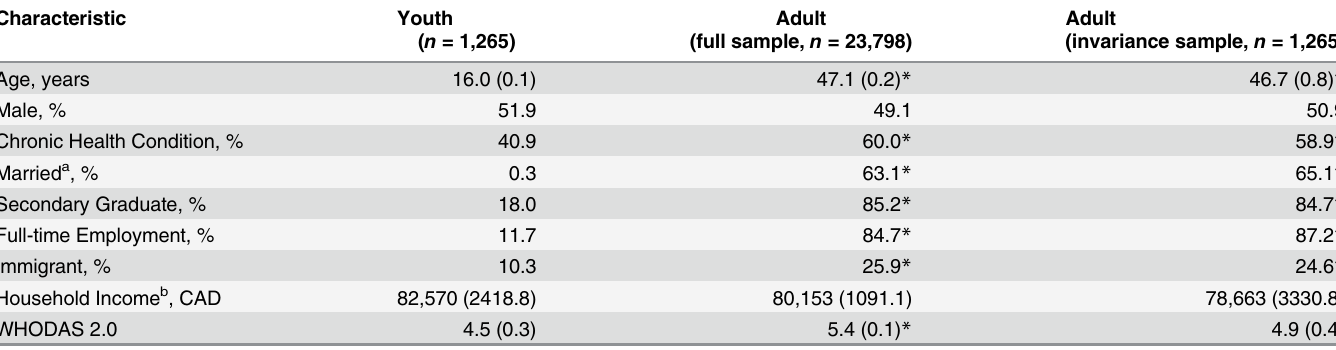
Table 2. Characteristics of Participants in the Canadian Community Health Survey-Mental Health.